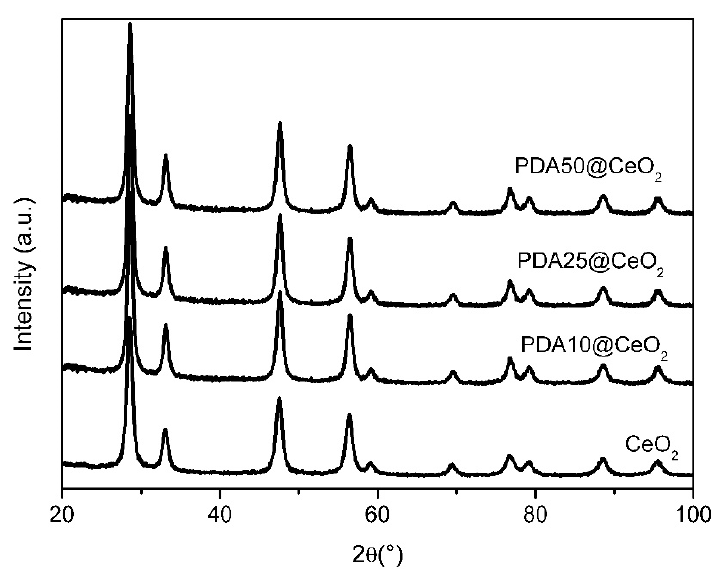
Figure 6. XRD patterns for pristine and coated CeO 2 .